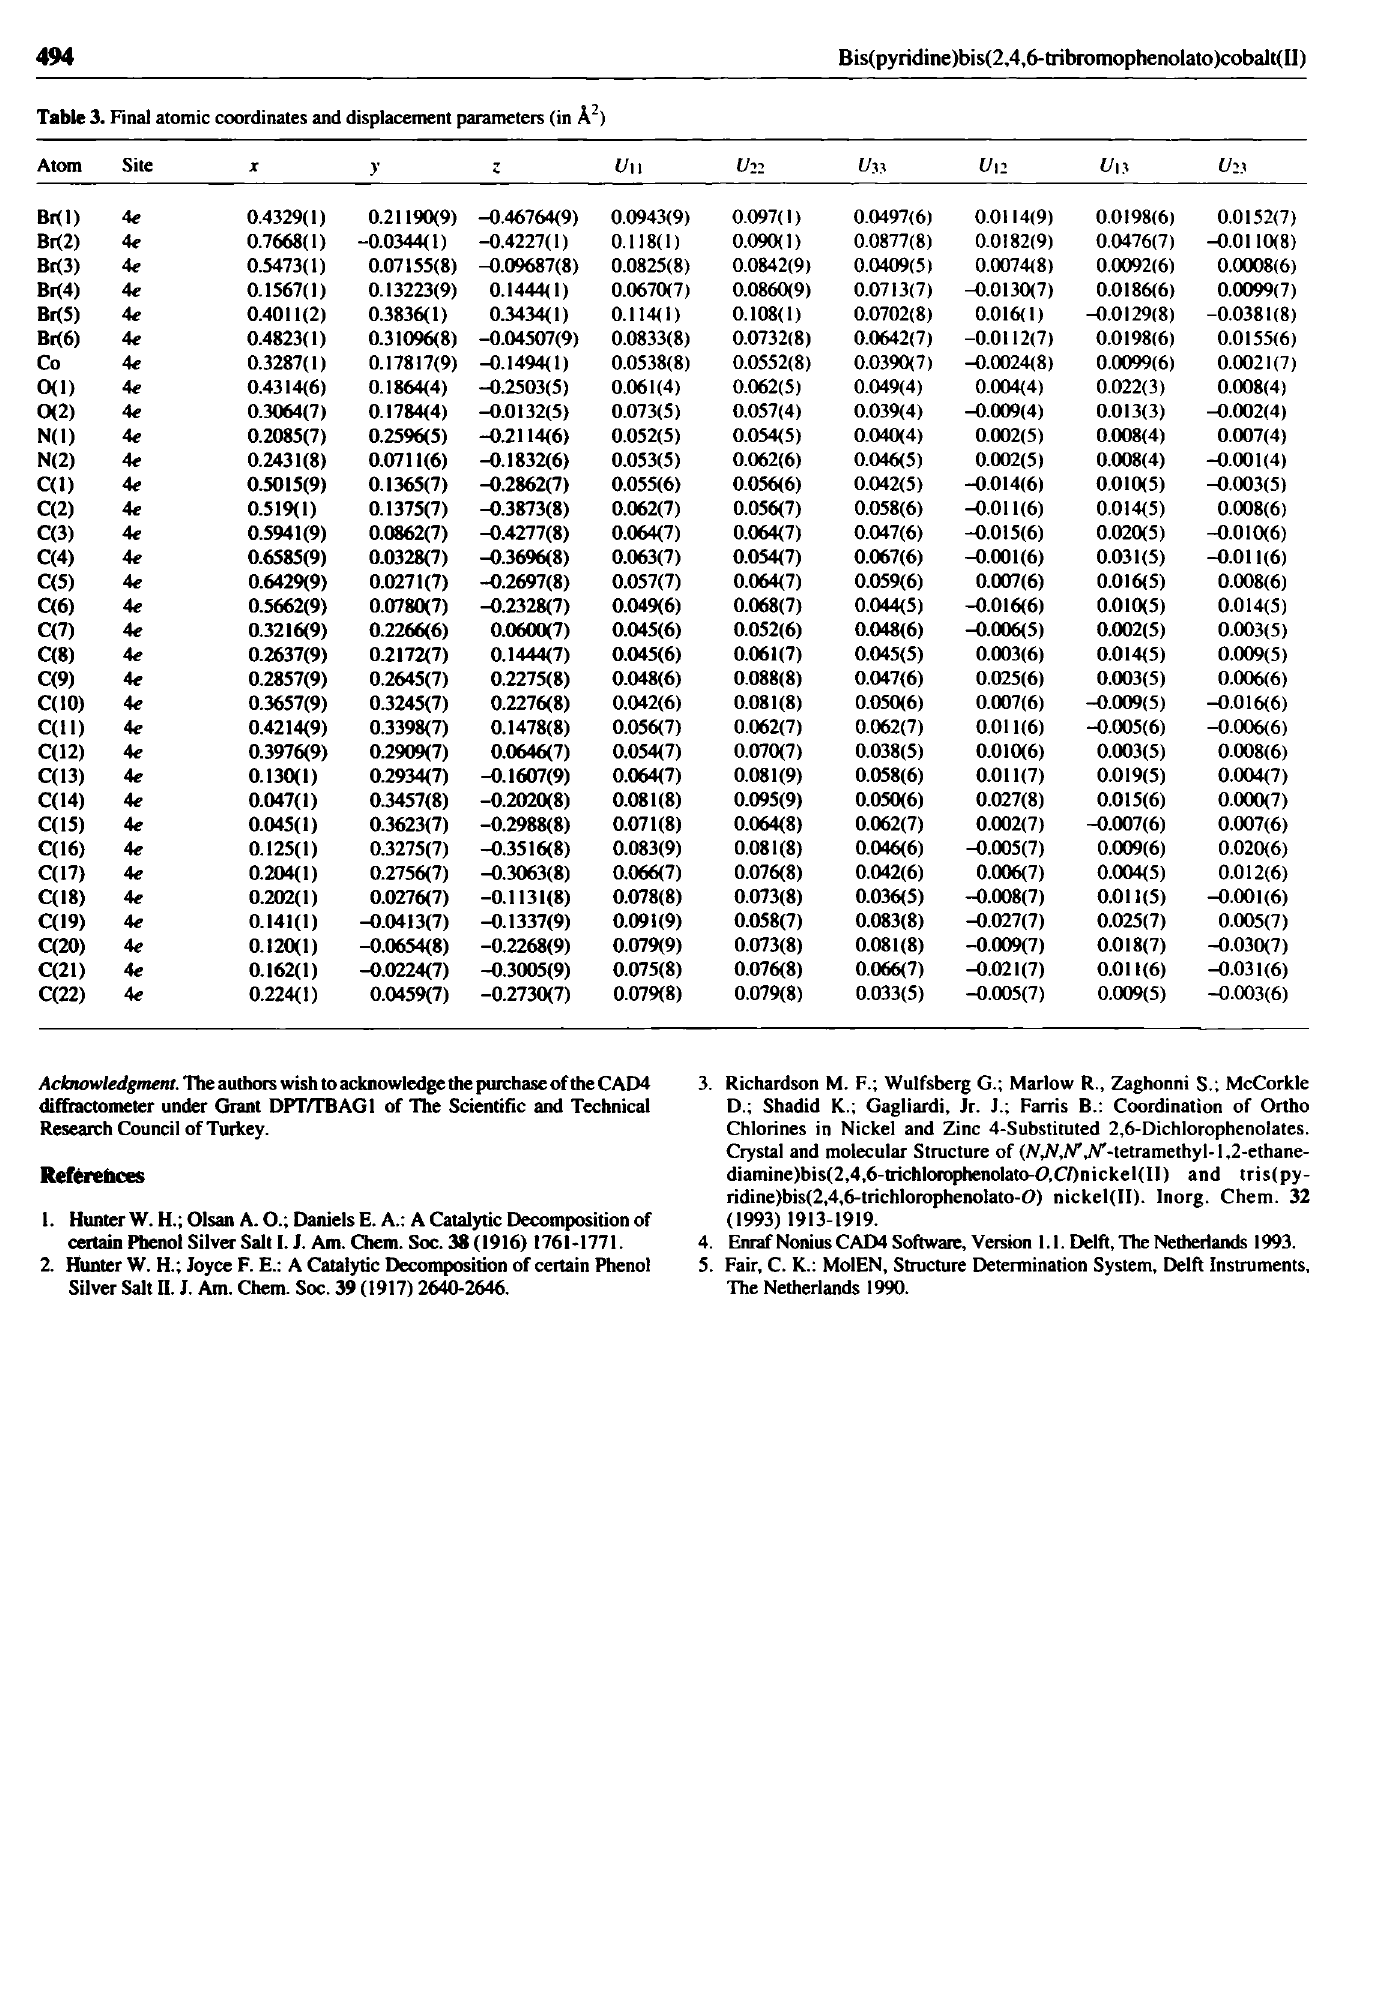
Table 3. Final atomic coordinates and displacement parameters (in Â 2